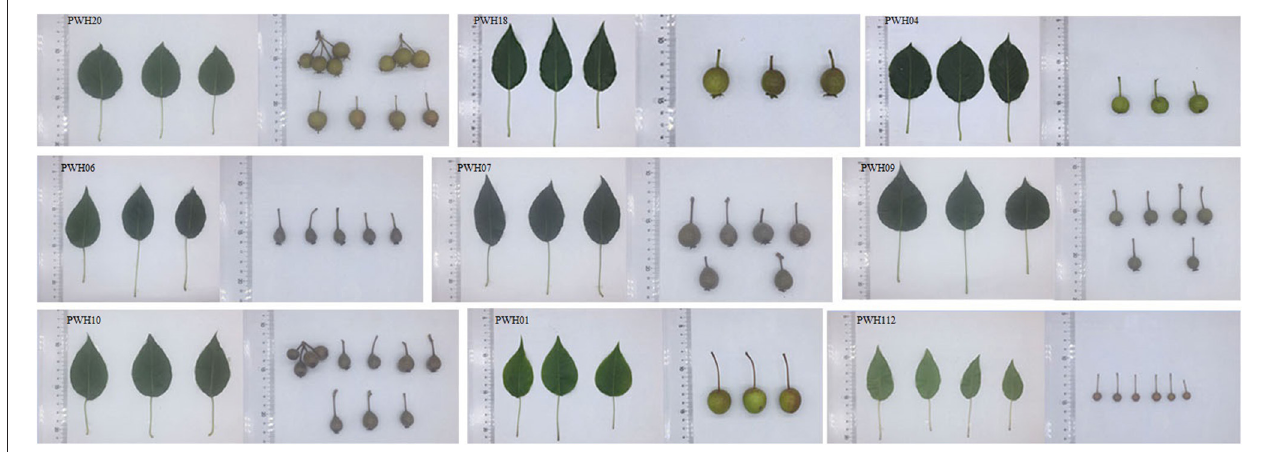
FIGURE 1 | Images of leaves and fruit of the nine wild pears (PWH01, PWH04, PWH06, PWH07, PWH09, PWH10, PWH12, PWH18, PWH20) included in this study.